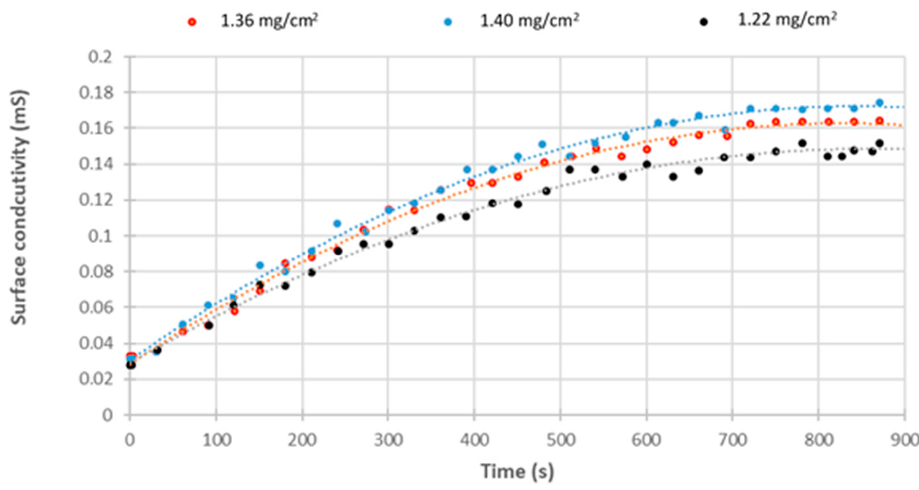
Figure 12. Example of three surface conductance evolutions obtained during the humidification period for an average ESDD of 1.34 mg/cm 2 .